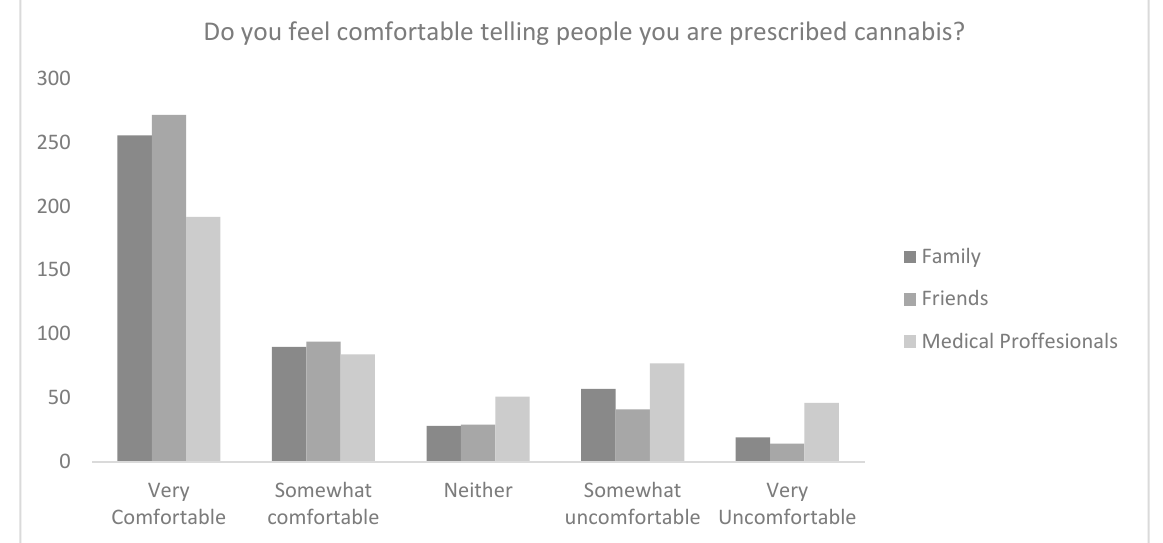
Figure 1. Raw responses to the question “Do you feel comfortable telling people you are pre- scribed